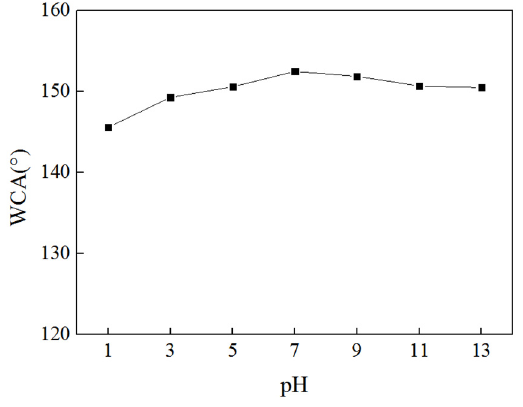
Figure 11. The CA of coating surfaces soaked in different pH solution for 30 min.